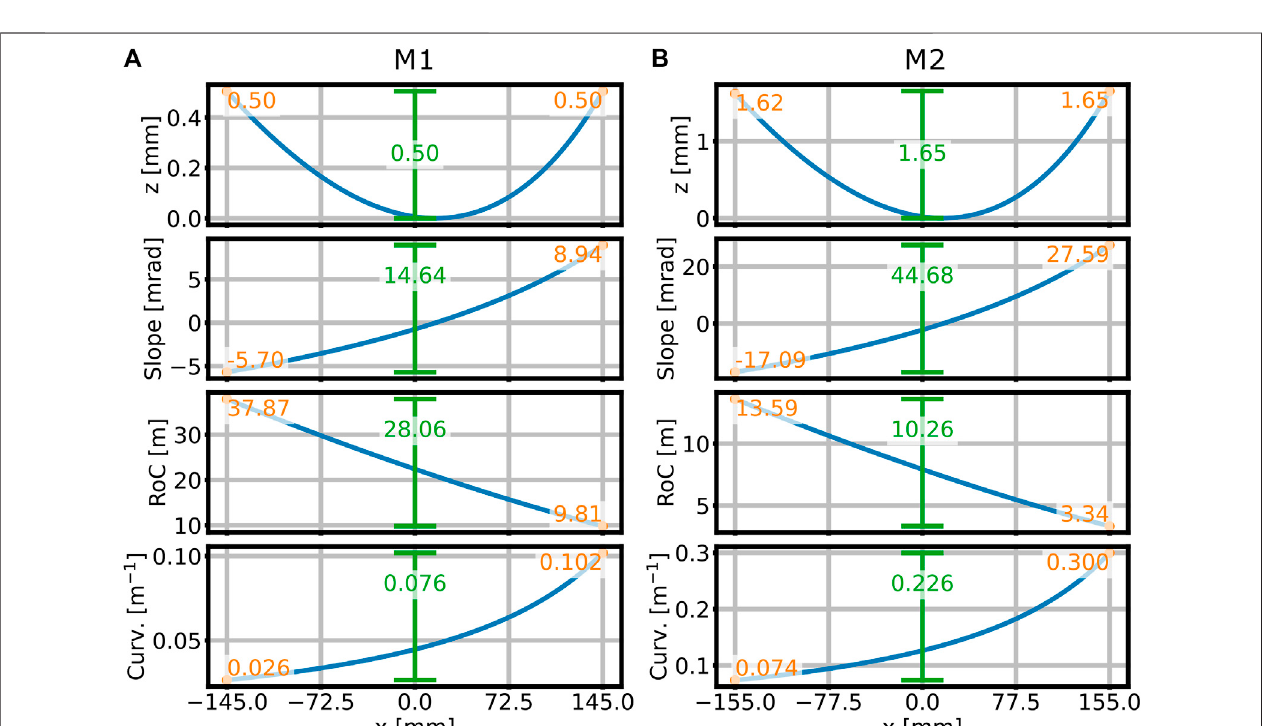
Frontiers in Physics |